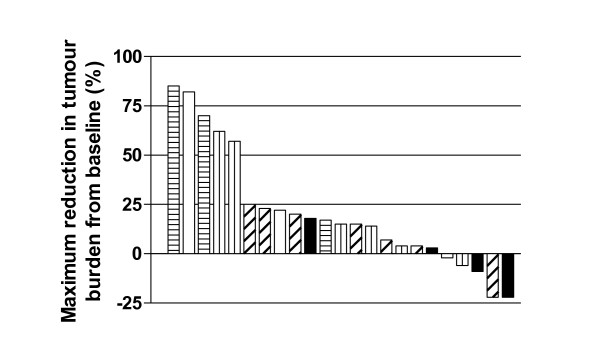
Waterfall plot of maximum reduction in tumour burden from baseline by dose level (135 mg/m2 (white fill), 270 mg/m2 (vertical lines), 540 mg/m2 (diagonal lines), 675 mg/m2 (horizonal lines) and 900 mg/m2 (black fill)).